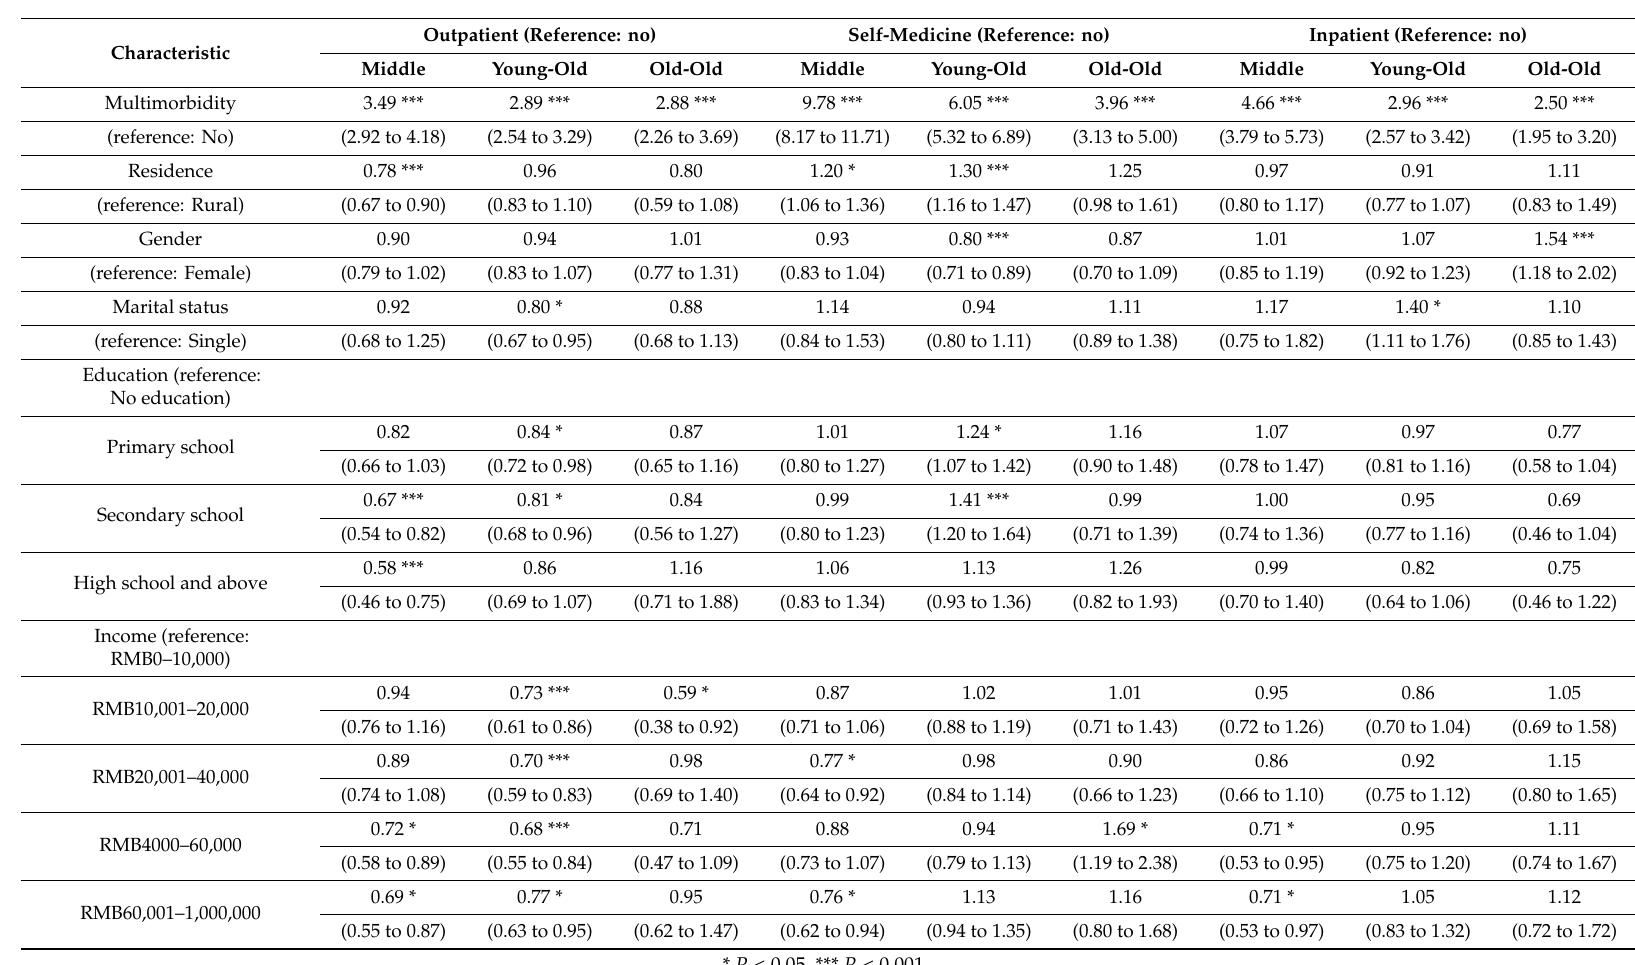
Table 4. Health service utilization of multimorbidity by age groups (OR,